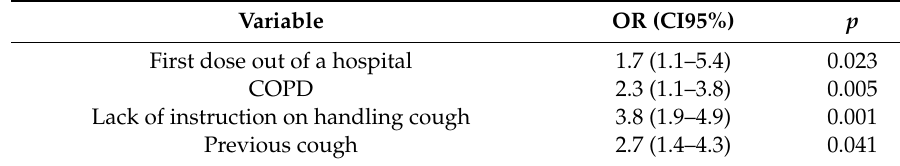
COPD: Chronic obstructive pulmonary disease. OR: Odds Ratio; CI: Confidence